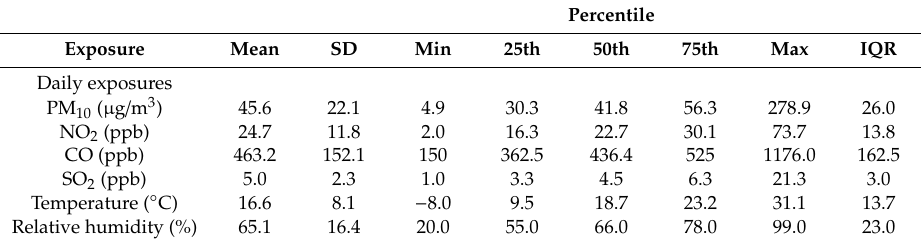
Table 2. Exposure level of air pollutants and meteorological indices during the study